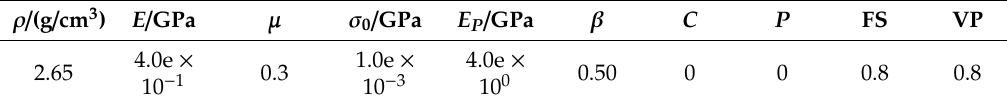
Table 5. Parameters of the concrete [41].